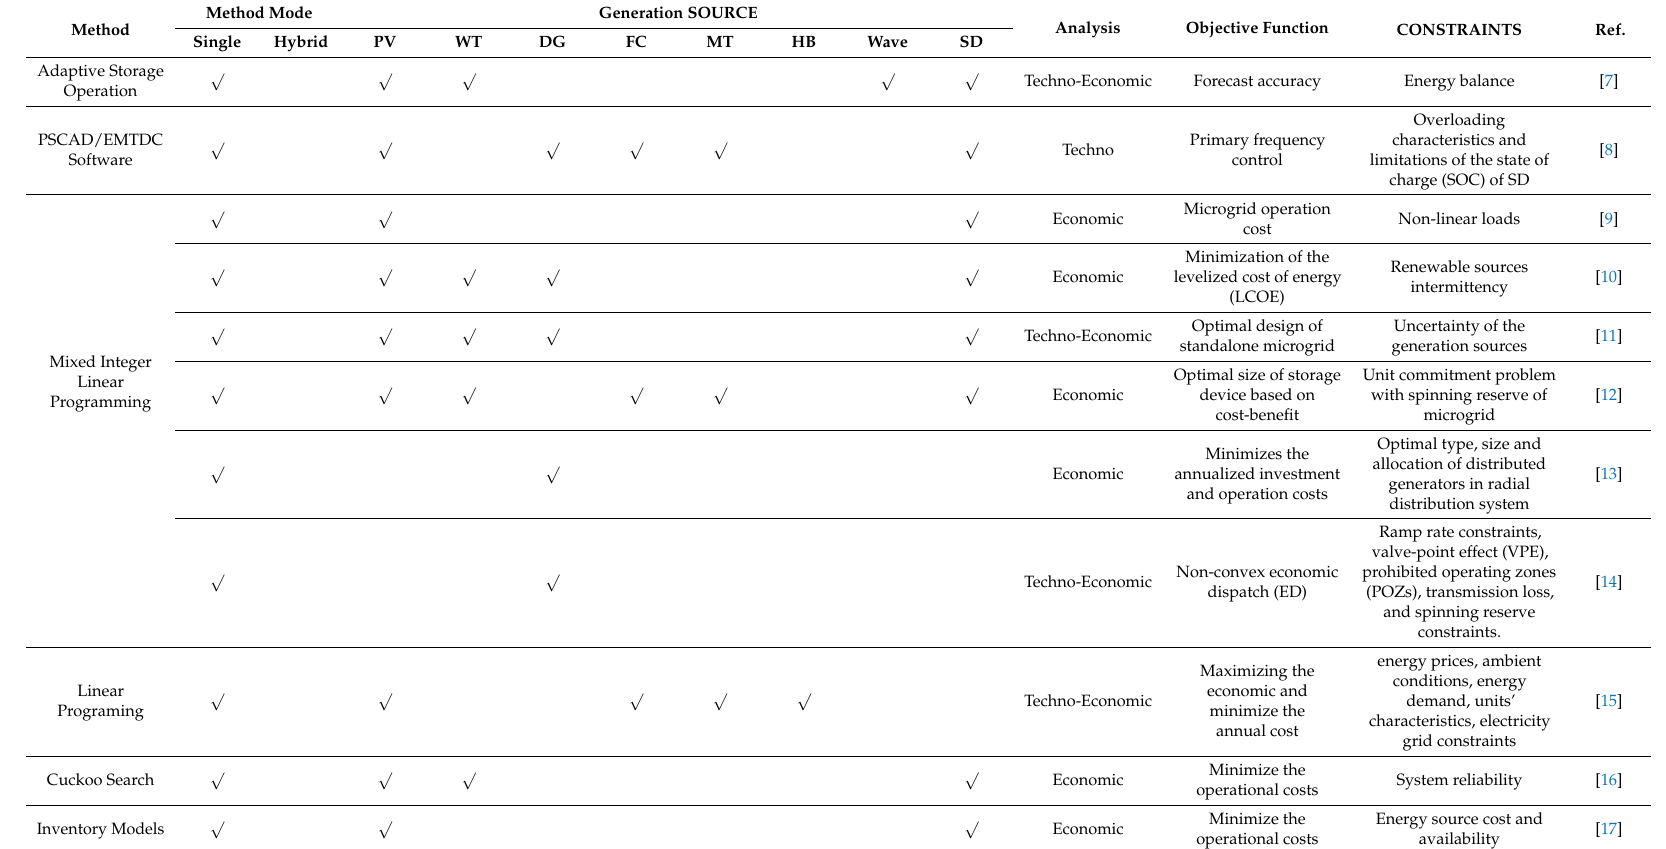
Table A1. Selected optimization